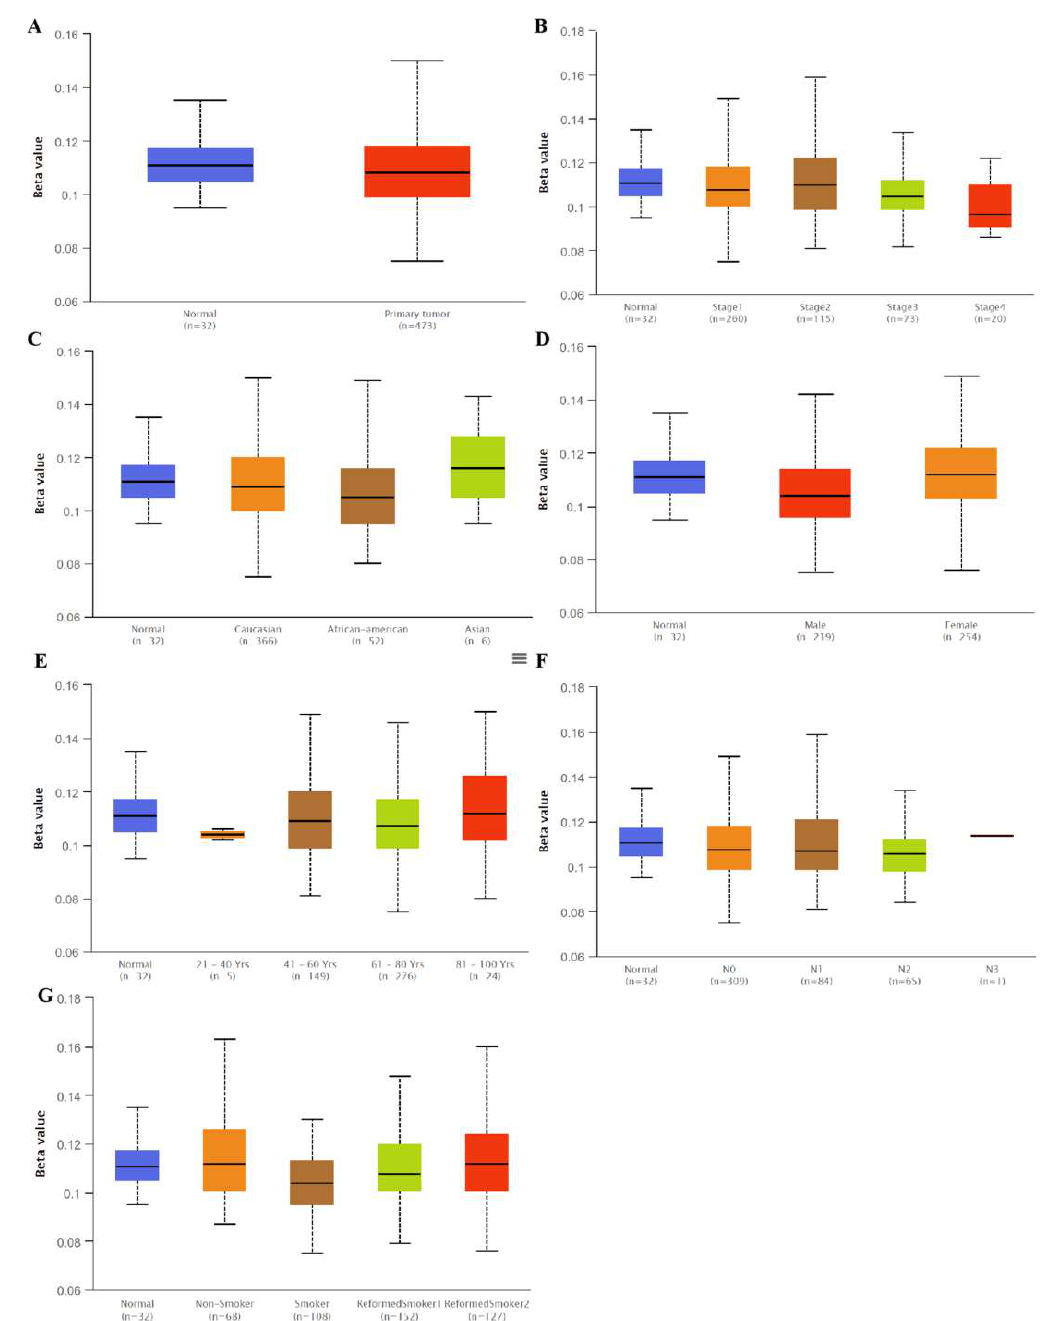
Figure 3. Methylation status of SLC3A2 in tumor tissues and in matched normal tissues from different subgroups of LUAD patients. ( A ) Sample type; ( B ) Stages; ( C ) Race; ( D ) Gender; ( E ) Age; ( F ) Nodel metastasis; ( G ) Smoking habits.